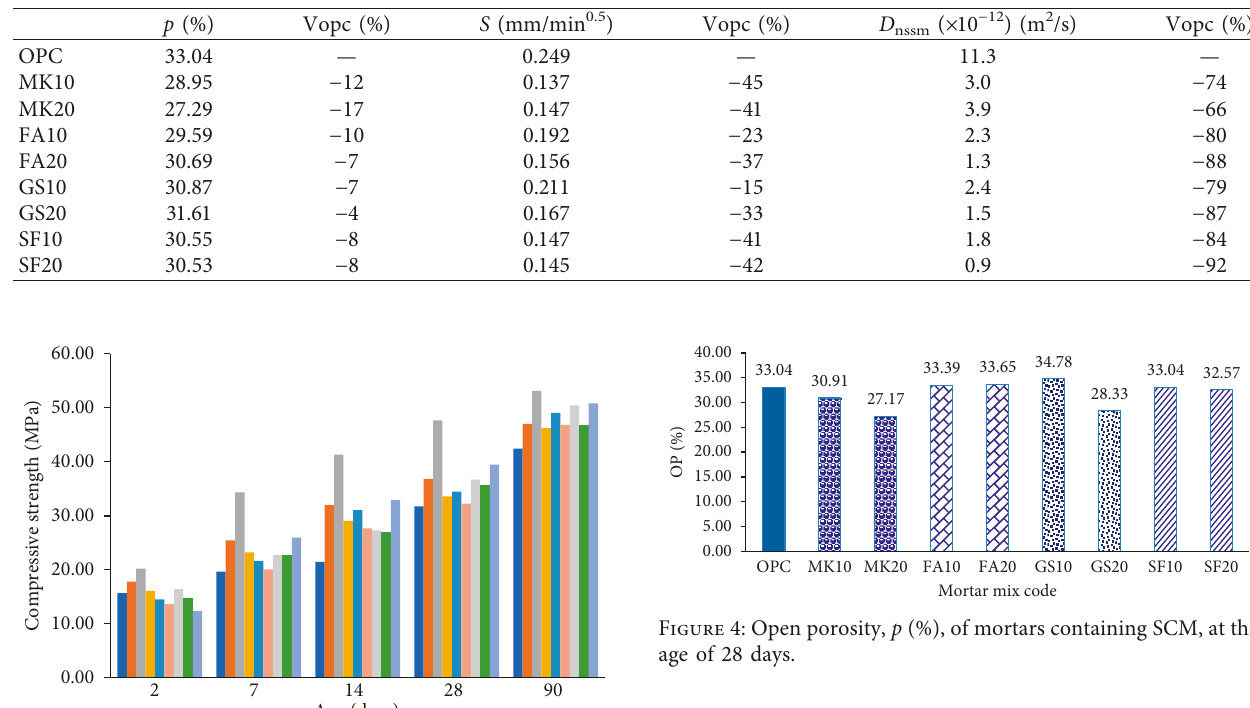
Table 5: Open porosity ( p ), sorptivity ( S ), and chloride penetration coefficient ( D values of OPC